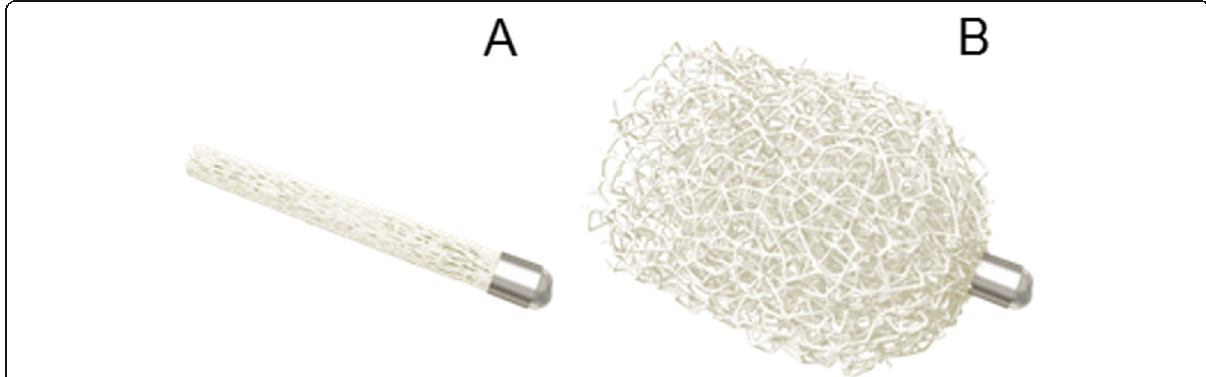
Fig. 1 The IMPEDE-FX Embolization Plug in its crimped ( a ) and expanded ( b ) state. Images were obtained with the permission from Shape Memory Medical